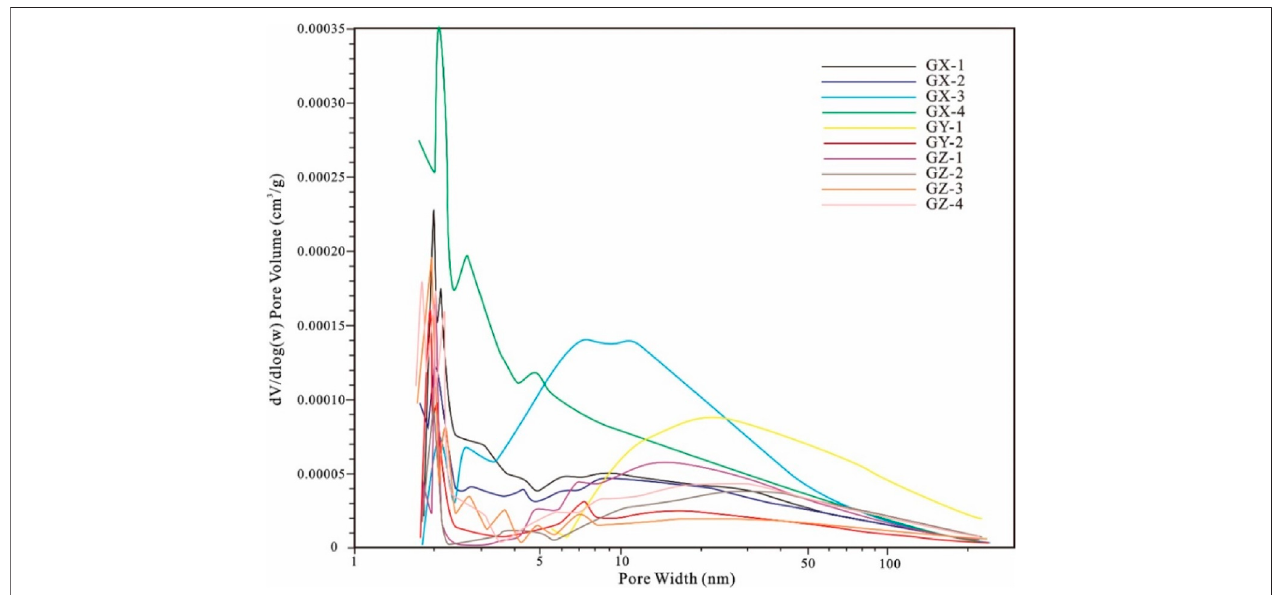
FIGURE 7 | Pore size distribution plotted based on nitrogen adsorption experiment results of shale samples.